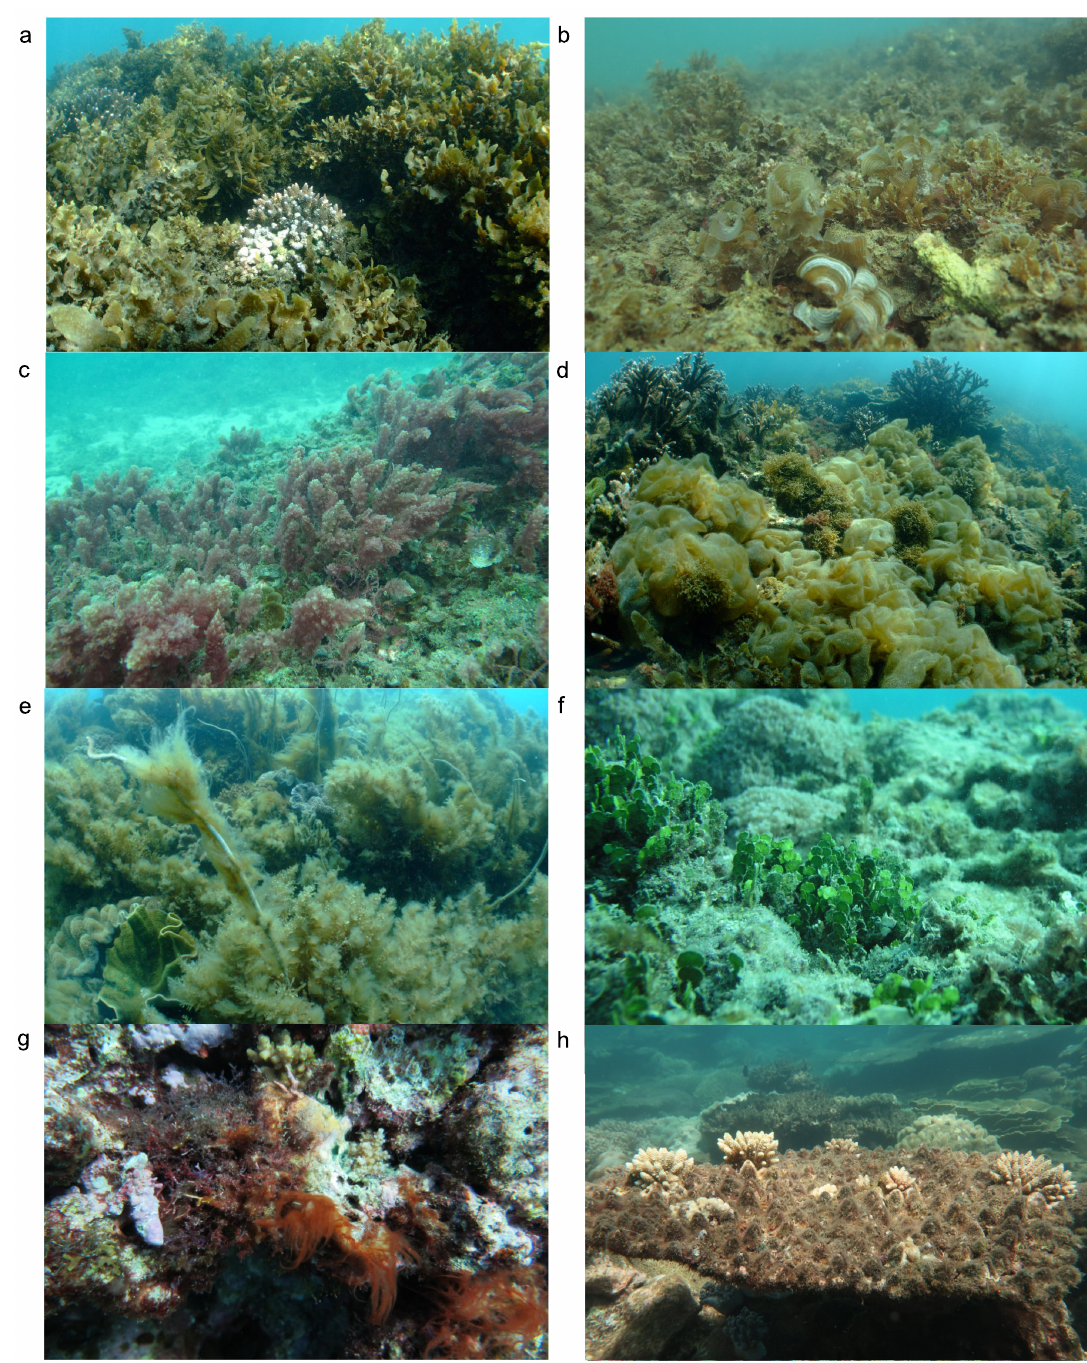
Fig 1. Examples of the major reef algal assemblages on the Great Barrier Reef. ( a, b) In turbid waters especially on shallow wave- exposed inshore sites, Sargassum , Padina , Lobophora and other members of the class Phaeophyceae can dominate reef communities ( a: Magnetic Island 2020; b: Havannah Reef 2007). ( c) The red alga Asparagopsis can be common on disturbed high-current reef sites (Havannah Reef). ( d) Relatively short-lived blooms of ephemeral Phaeophyceae can create anoxic conditions that may kill corals (Magnetic Island 2019). ( e) Spring blooms of filamentous algae predominantly occur in high-nutrient environments and can be lethal for other reef benthos especially during senescence (Dingo Beach, Whitsundays). ( f) On offshore reefs, the calcareous macroalga Halimeda can occupy extensive areas (Green Island). ( g) Cyanobacteria may cover large reef areas after disturbance, but these blooms are functionally different from macroalgae and are excluded here from ‘total macroalgal cover’ (John Brewer Reef). ( h) Turf algae, rather than macroalgae, occupy GBR reefs after disturbances in many environmental conditions (see Results) (Russell Island). Photos: a,c,d,e,g, h: K. Fabricius, AIMS; b,f: LTMP, AIMS.